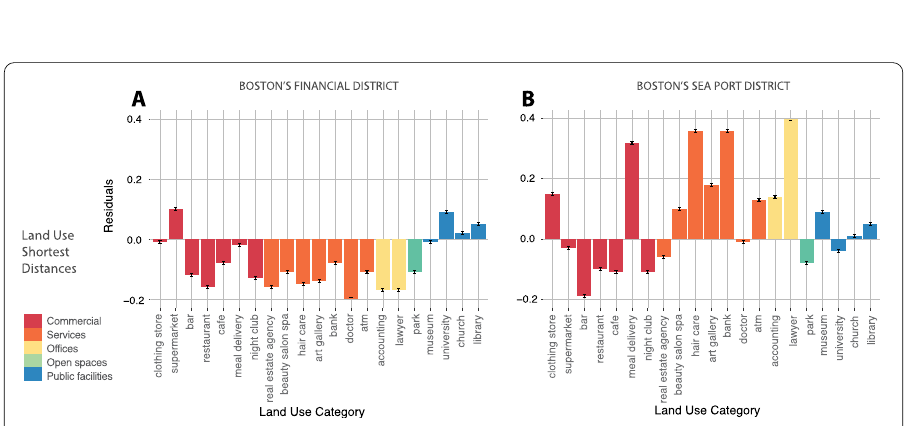
Figure 6 Deviationsfromexpecteddistancebetweenamenities . ( A ) In Boston’s financial district, for most of the amenity types the mean shortest distance is shorter than one would expect given the density of amenities. ( B ) On the contrary, in Boston’s seaport district, many amenity types are farther than one would expect